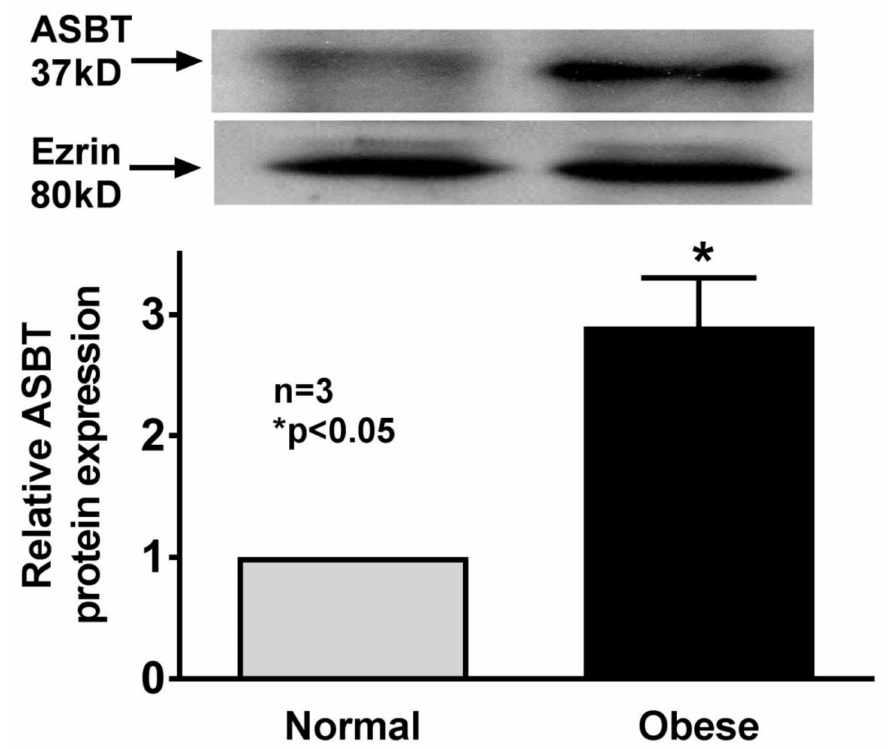
Figure 5. Na–bile acid cotransport expression in human distal ileal villus cells. ASBT expression was significantly increased in villus cells from obese human ileum compared to normal BMI human